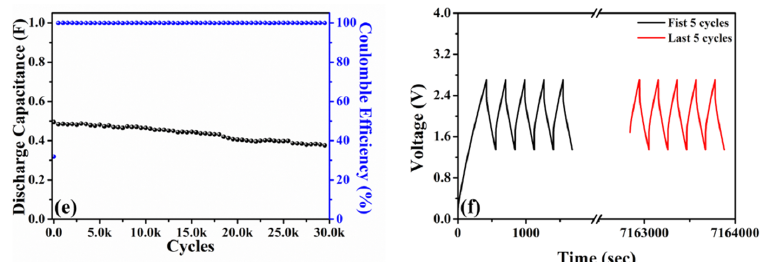
Figure 7. ( a ) Galvanostatic charge–discharge profiles, ( b ) rate capabilities, ( c ) electrochemical impedance spectra, ( d ) Ragone plots, ( e ) discharge capacitance as a function of cycle number of the H@H electrode in a coin-type symmetric cell, and ( f ) galvanostatic charge–discharge profiles of the first and last five cycles received from ( e ). The inset of ( c ) illustrates the equivalent circuit model used for the parameter fitting [45].